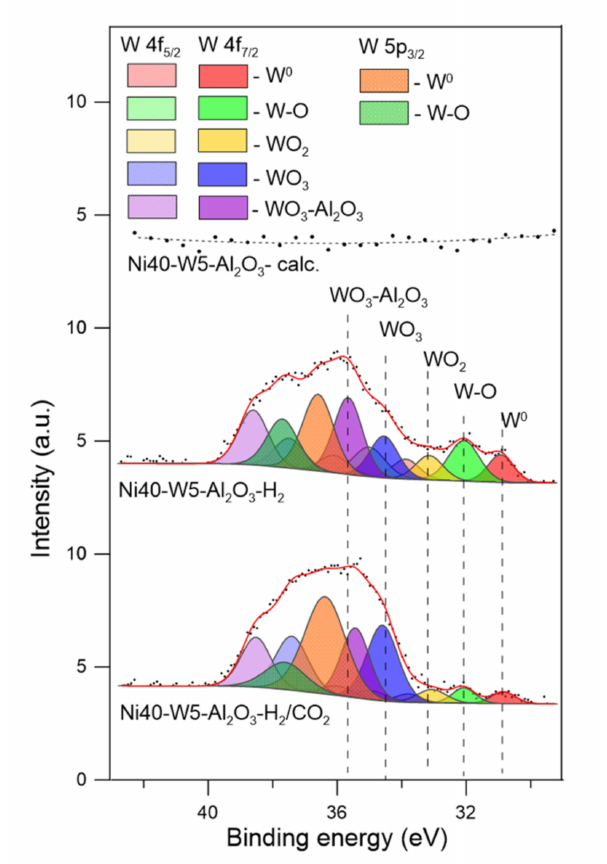
Figure 10. W 4f and W 5p XPS spectra of catalysts after calcination (-calc.), activation in hydrogen (-H 2 ), and CO 2 methanation reaction (-H 2 /CO 2